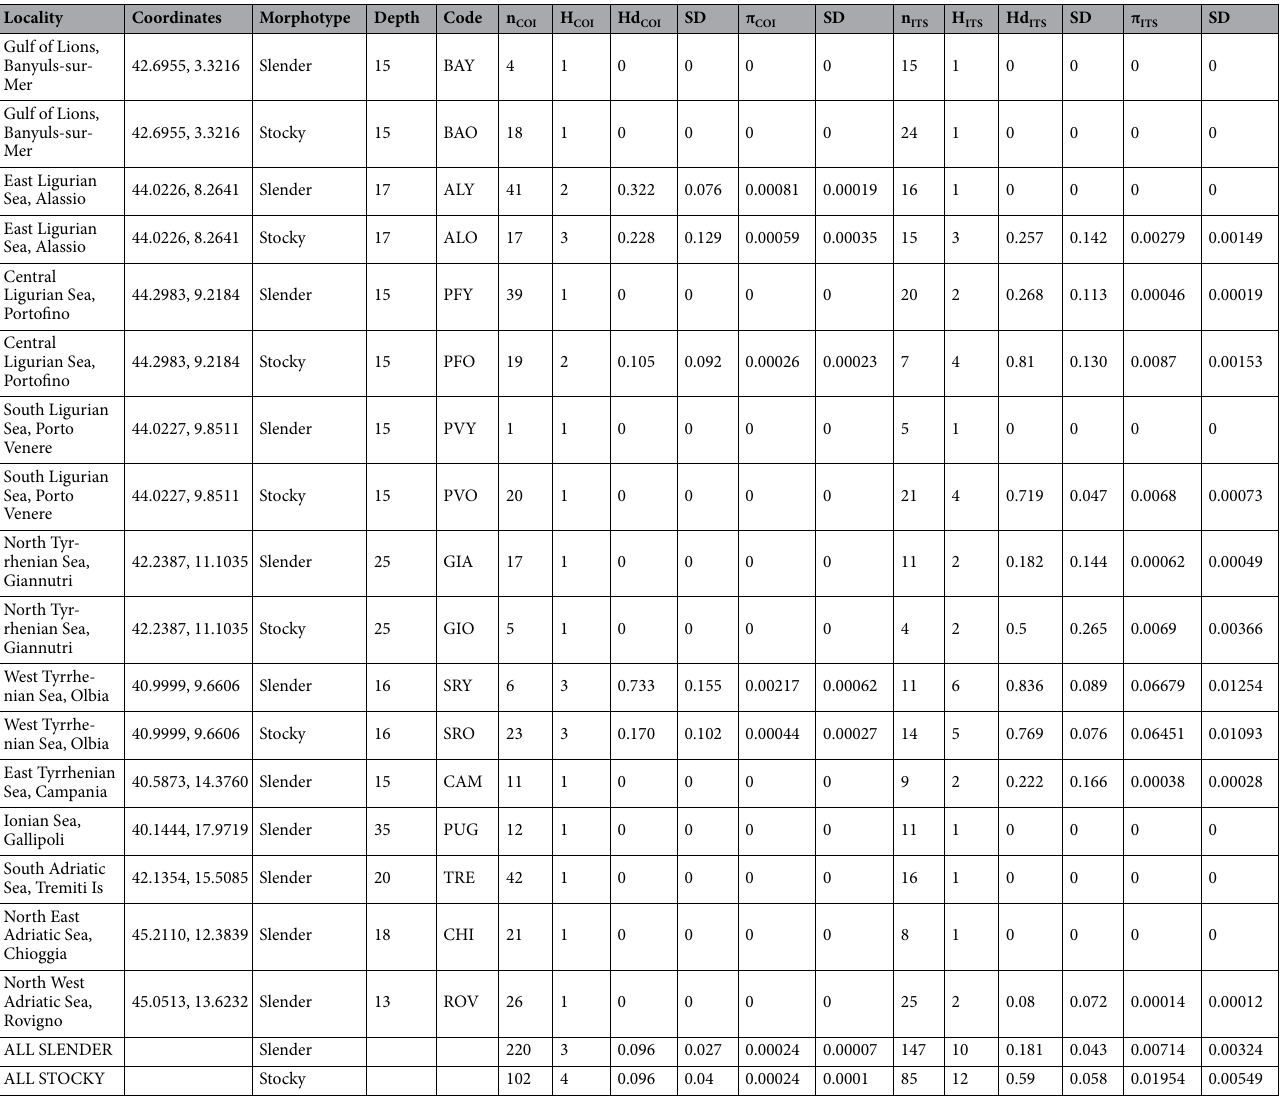
Table 1. Locality, geographical coordinates, morphotype, depth, and code of Parazoanthus axinellae samples; number of individuals sequenced (n), haplotypes (H), haplotype (Hd) and nucleotide (π) diversity values per location (with their standard deviation—SD) for both molecular